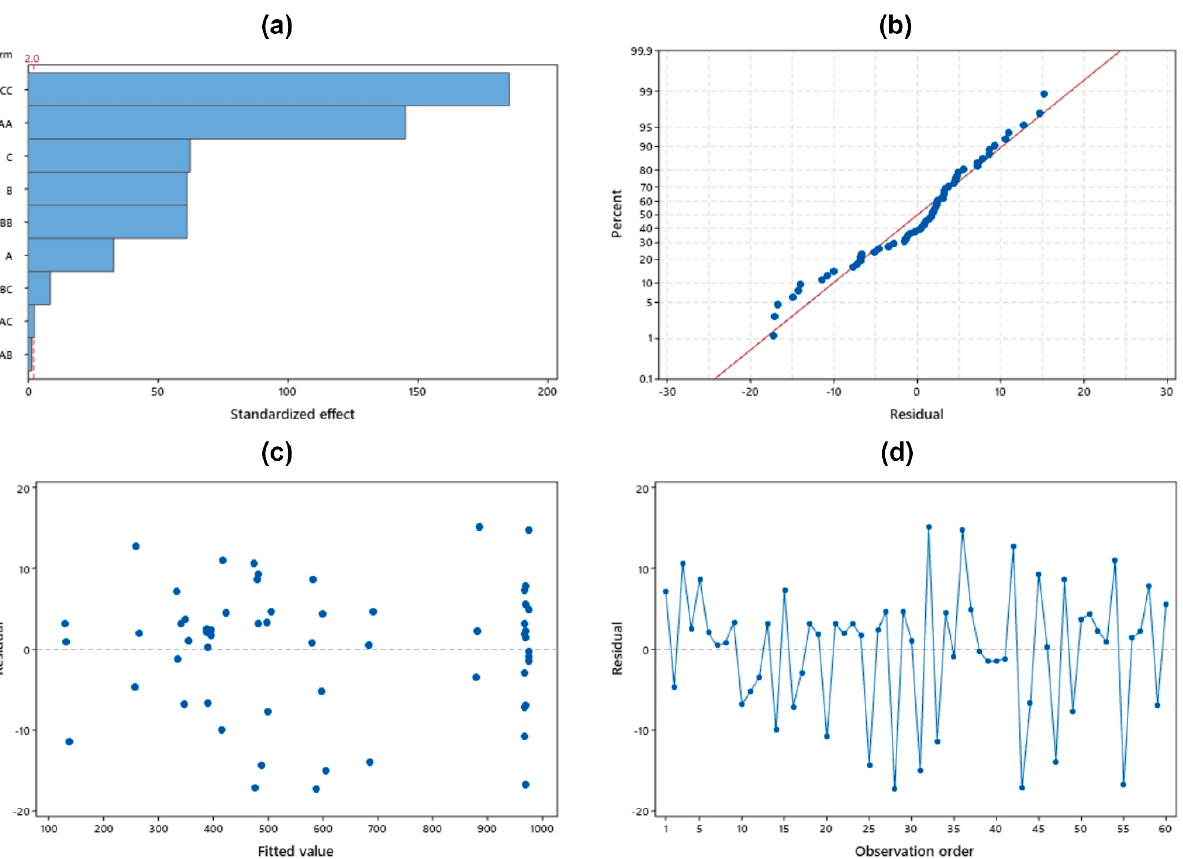
Figure 2. Condition of statistical study interpreted using ( a ) Pareto chart, ( b ) normal probability plot, ( c ) residuals versus fits plot, and ( d ) residuals versus order plot.